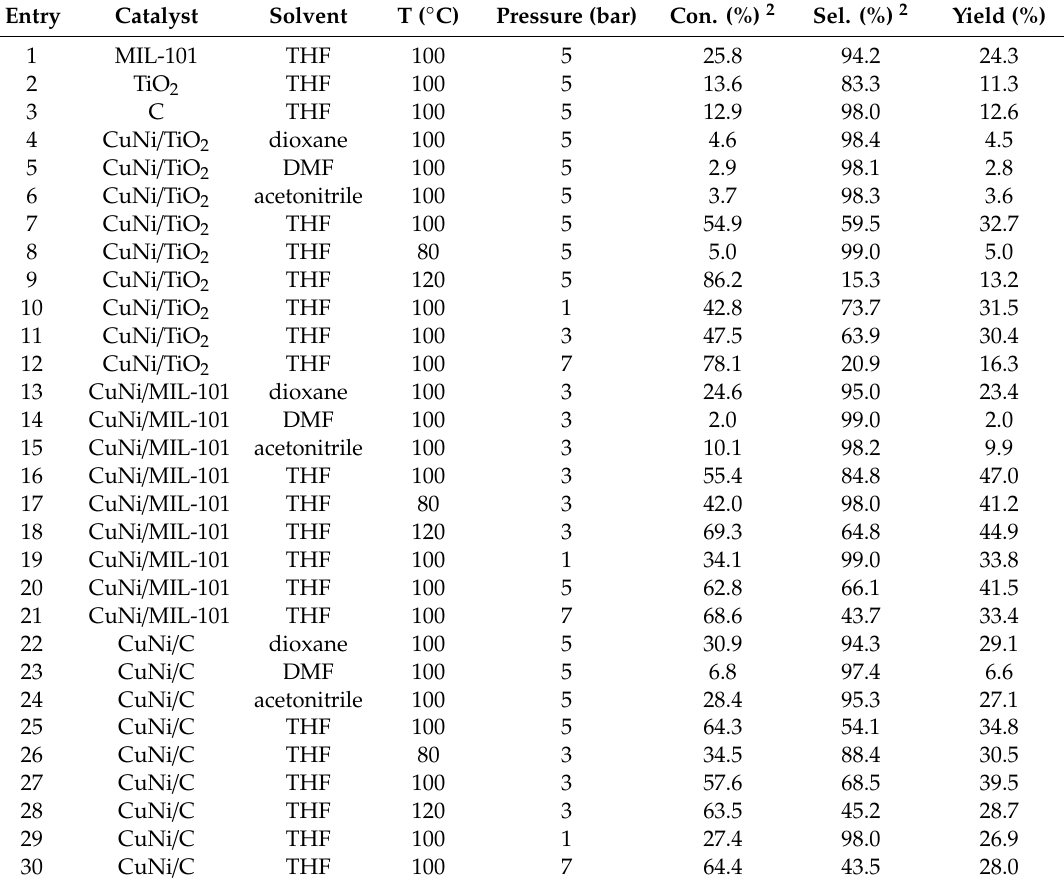
Table 2. The catalytic activity of the catalyst in the selective oxidation of benzyl alcohol to benzaldehyde 1